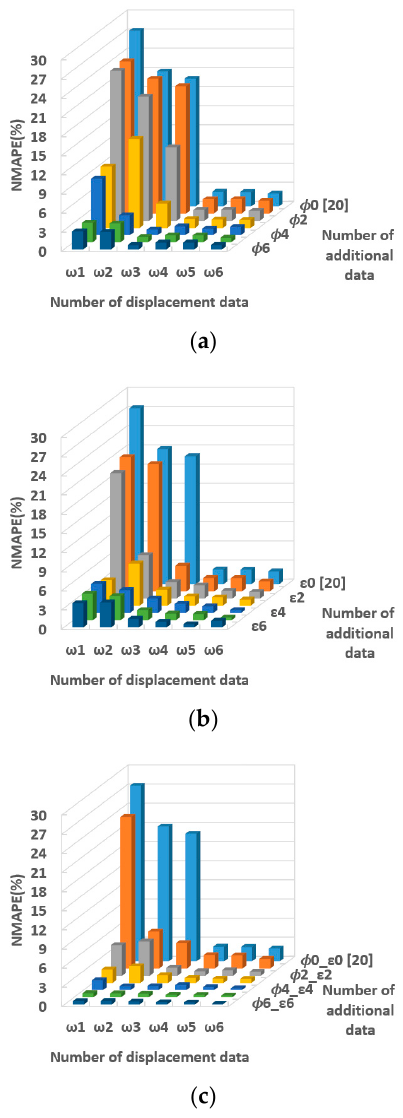
Figure 23. NMAPE according to the number and combination of sensors (RDS4): ( a ) displacement + slope, ( b ) displacement + strain, ( c ) displacement + slope + strain.